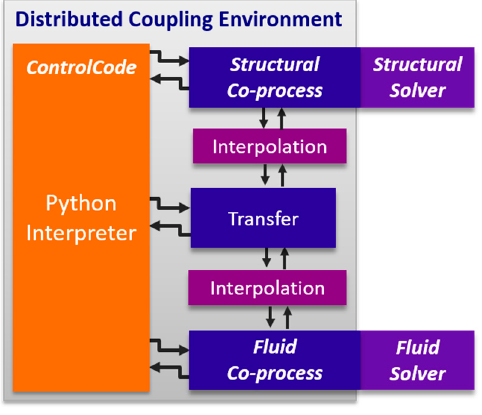
Figure 1. Coupling environment ifls (see [25–27]).